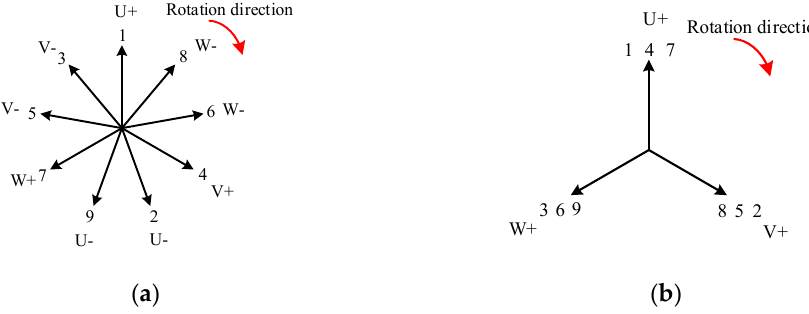
Figure 5. Slot vector diagrams. ( a ) 4-pole-pair number. ( b ) 12-pole-pair number.